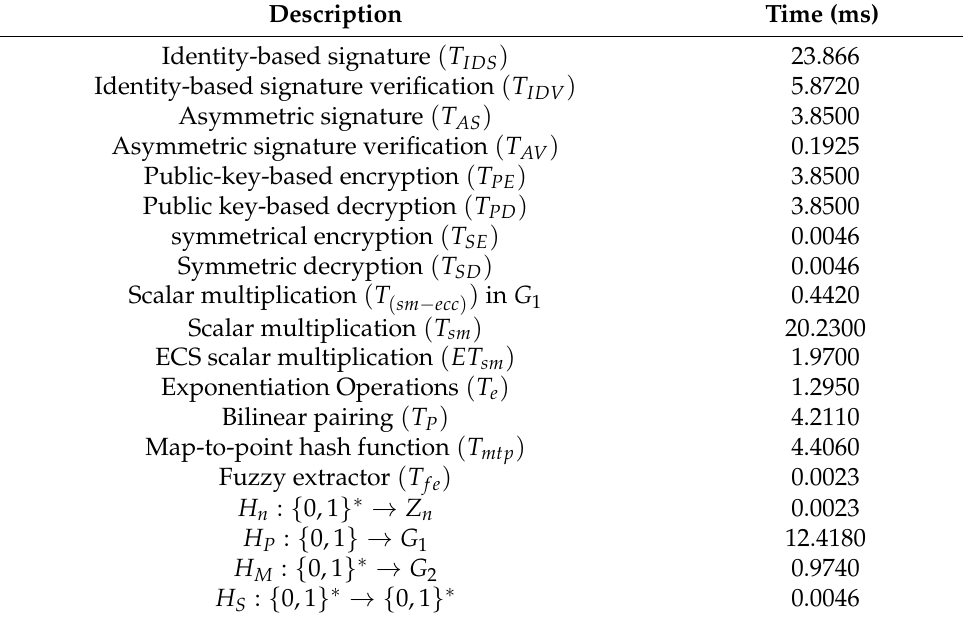
Table 6. Computation time